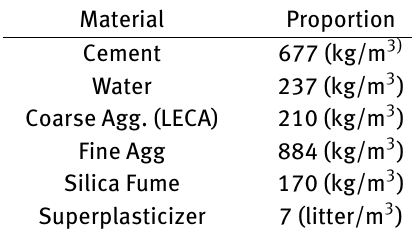
Table 1: The adopted lightweight concrete mix